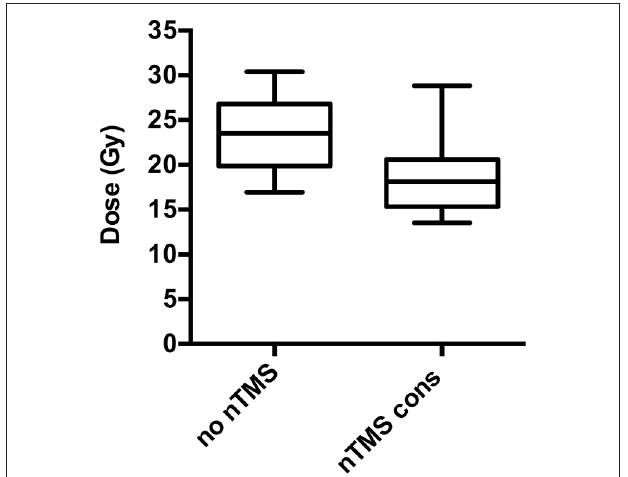
FIGURE 3 | Change of dose to motor maps. Radiation dose to the navigated transcranial magnetic stimulation (nTMS) motor maps can be significantly reduced in radiotherapy (RT) planning. The box plots represent the dosage applied to the nTMS motor maps. Regarding conventional RT plans not taking nTMS motor maps into account (“no nTMS”), the mean dose (Dmean) is 23.0Gy compared to 18.9Gy ( p < 0.001) for RT plans with constraints to the nTMS motor maps (“nTMS cons”).